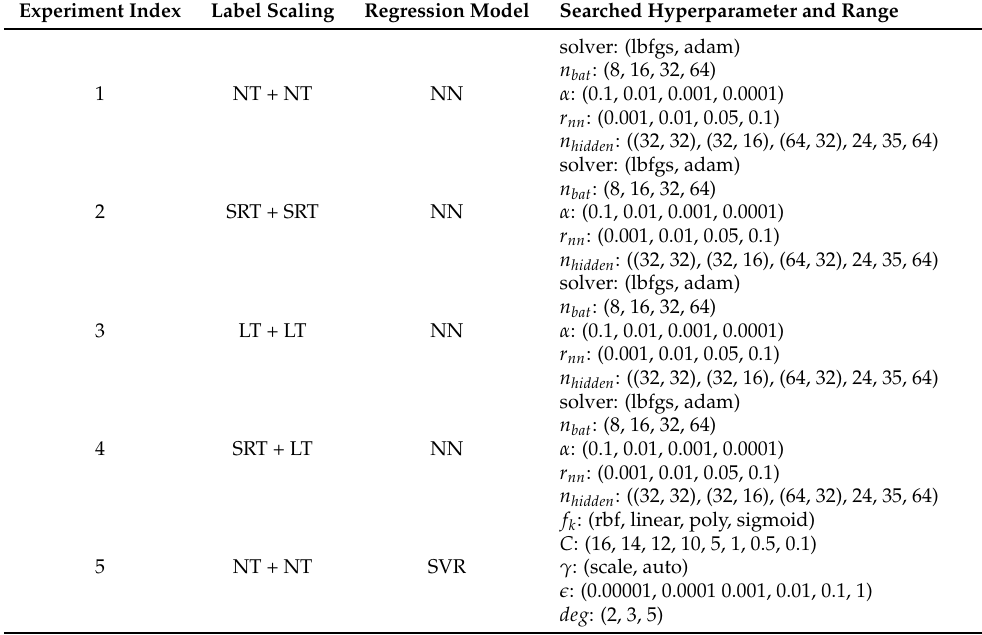
Table 2. Experiments of regression model training